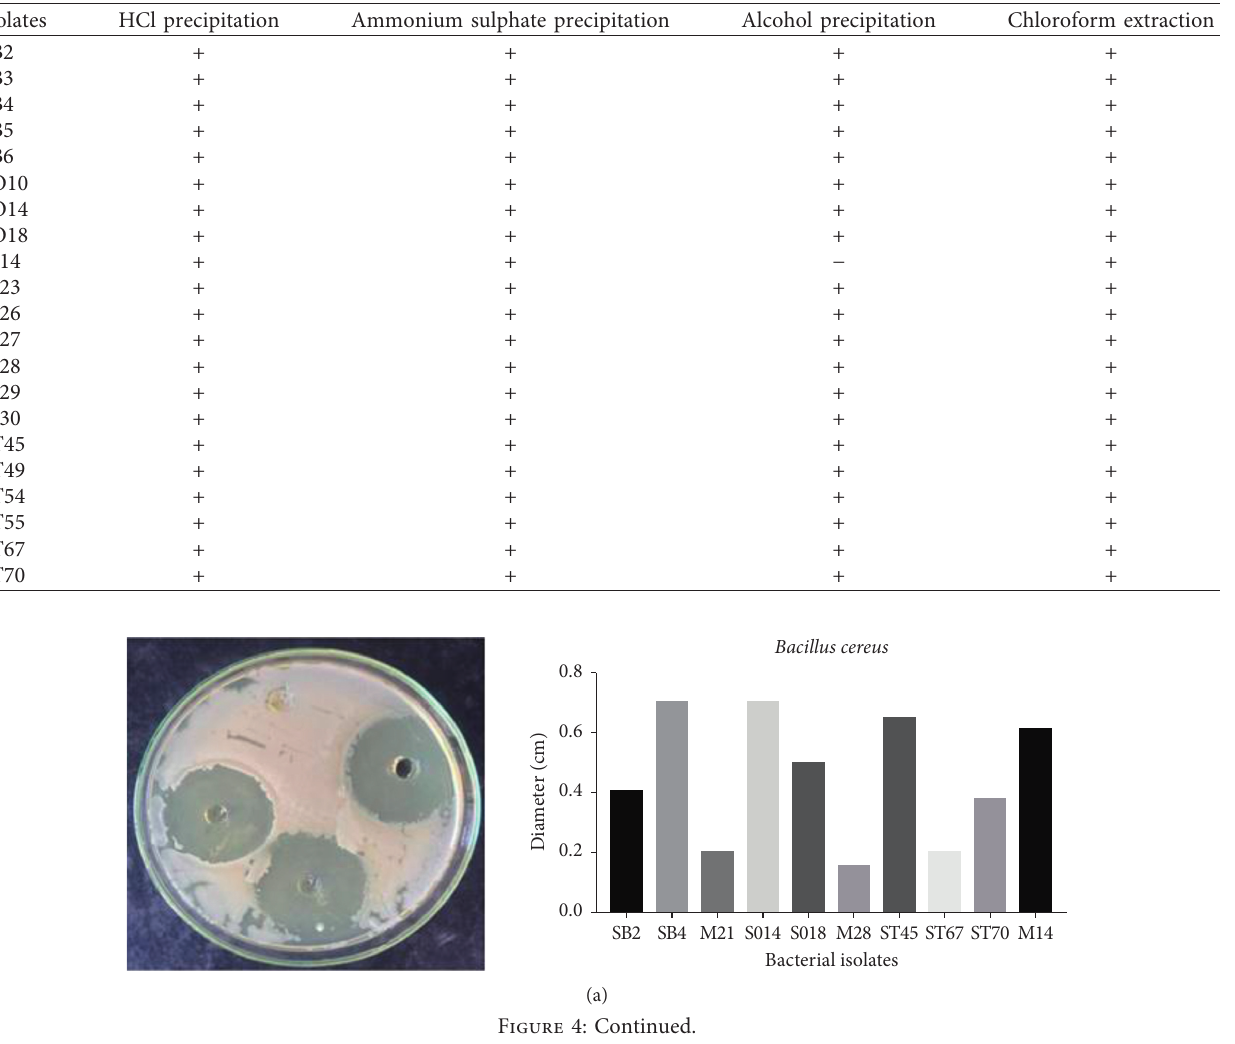
Figure 3: Emulsification activity of Bacillus isolates with hexane, gasoline, and diesel fuel at different temperatures. Bacillus species isolates are SB1, SB2, SB3, SB4, SB5, SB6, SB7, SB8, SO5, SO9, SO10, SO14, SO17, SO18, M14, M21, M22, M23, M24, M25, M26, M27, M28, M29, Table 2: Biosurfactants profiles secreted by Bacillus sp.